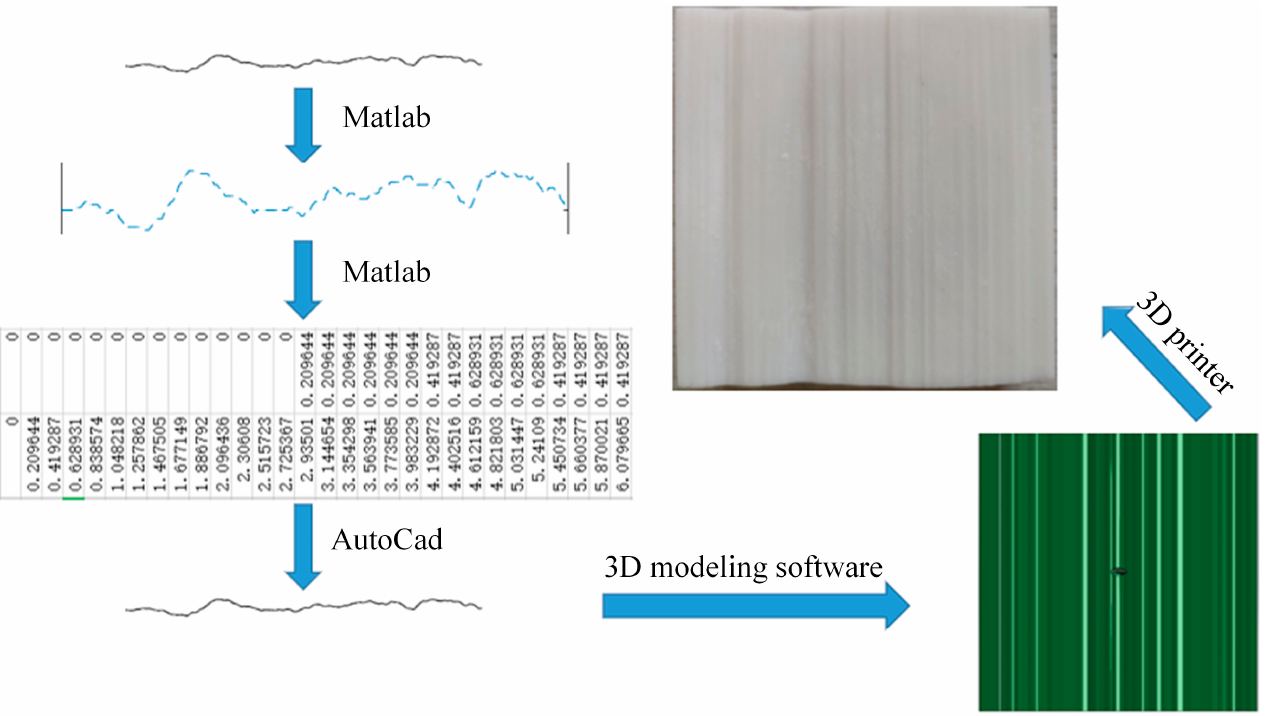
Figure 2. The realization process of resin plates recorded with the information of JRC.